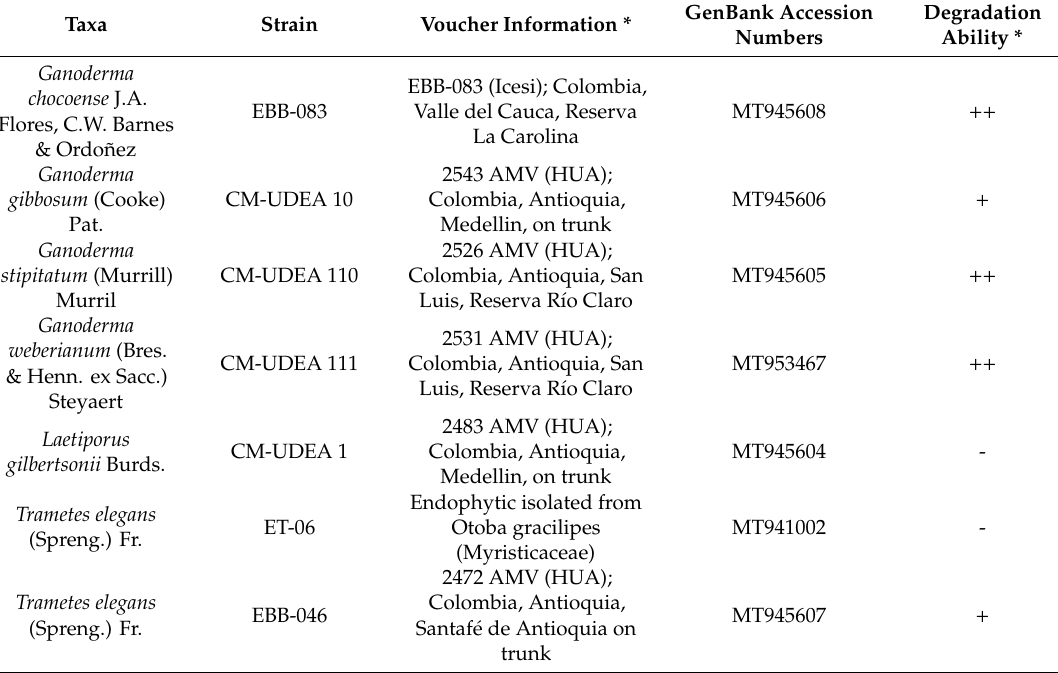
Table 1. List of fungal strains used in this